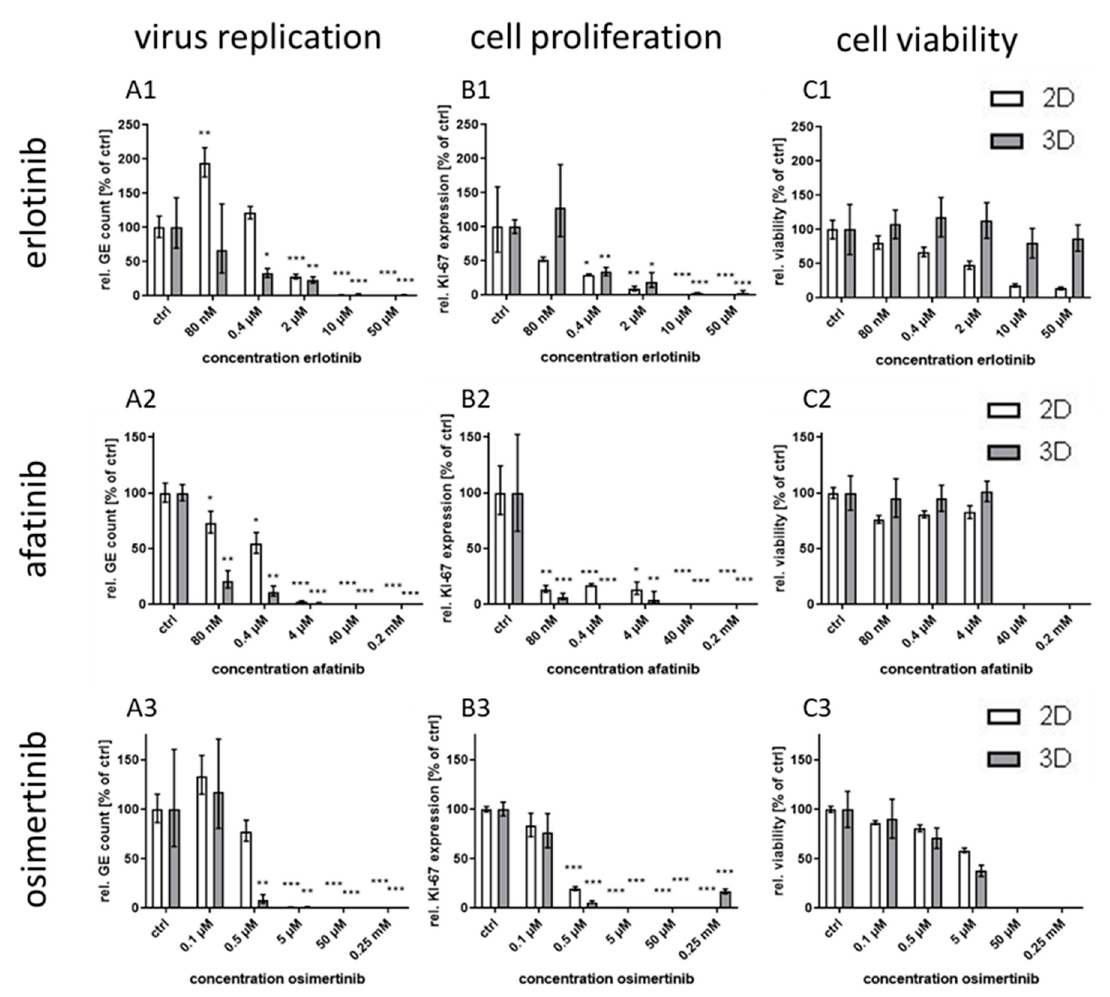
Figure 3. Effect of different RTKIs on CPXV infection in primary 3D and 2D cultures. NHEK were grown either in monolayer or as 3D cultures for 48 h. Cells were infected at an MOI of 0.1 and treated with different RTKI concentrations ( n = 3). At 48 h p.i. viral GE were quantified via qPCR and described as GE per cell. All RTKI-treated samples were normalized to infected untreated controls ( A ). Expression of the cellular proliferation marker KI-67 ( B ) was determined via qPCR, normalized to the cellular reference gene MYC , and expressed relative to the untreated controls. Statistical significance of reduction relative to the respective controls was calculated by two-tailed Student’s t -test (* p < 0.05, ** p < 0.01, *** p < 0.001). Cell viability was determined by ATP measurement with the cell viability assay CellTiter-Glo ® (Promega). Infected but untreated controls ( n = 2) were taken as 100%. Ratios of treated samples ( n = 2) to corresponding controls are illustrated as relative viability ( C ).